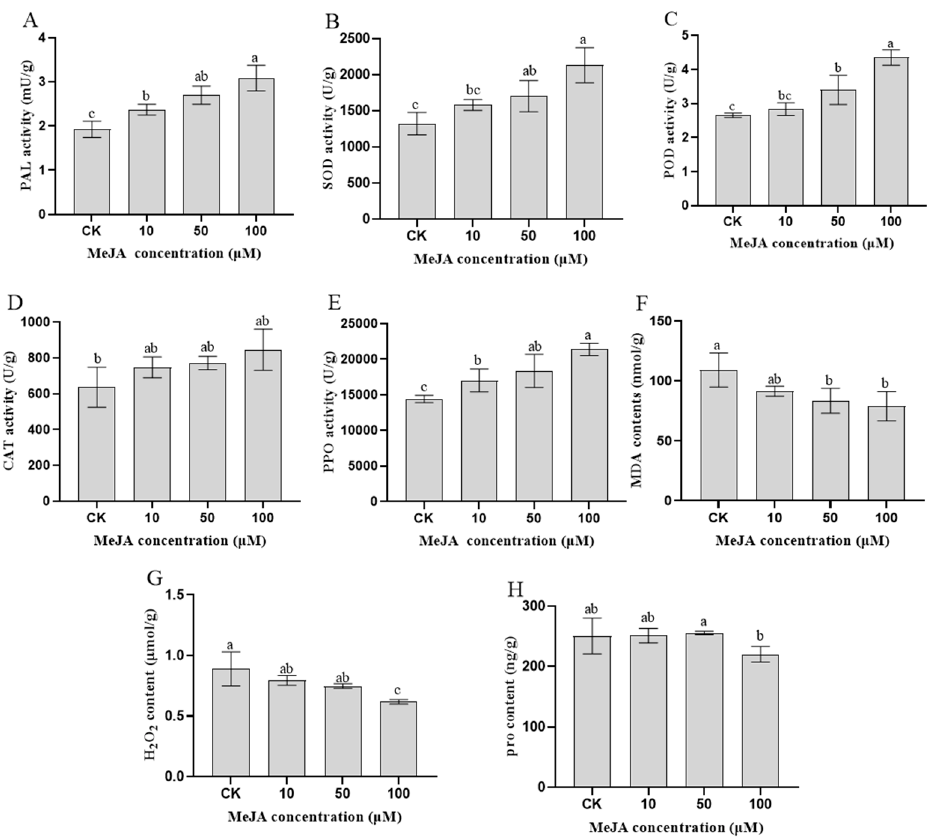
Figure 1. Physiological and biochemical indicators of rosemary suspension cells under different concentrations of MeJA. ( A ) changes in PAL activities. ( B ) changes in SOD activities. ( C ) changes in POD activities. ( D ) changes in CAT activities. ( E ) changes in PPO activities. ( F ) changes in MDA contents. ( G ) changes in H 2 O 2 contents. ( H ) changes in proline contents. Values represent means ± SDs of three replicates. Different lower-case letters indicate statistically significant differences at the 0.05 level by one-way ANOVA with Duncan’s test.